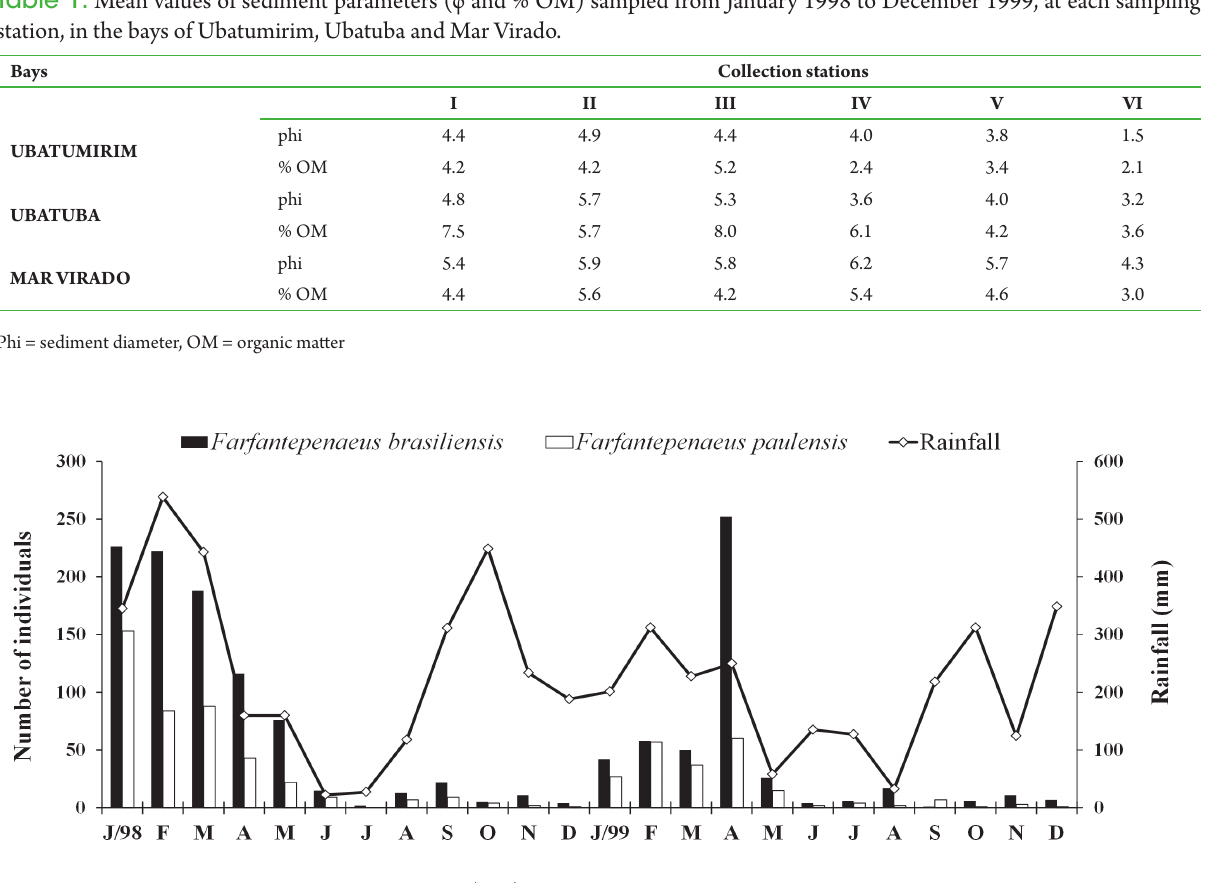
Figure 4. Cumulative values for monthly rainfall (mm) and number of individuals of Farfantepenaeus brasiliensis and F. paulensis sampled from January 1998 to December 1999 at Ubatuba, São Paulo. Table 2. Results of nested ANOVA for the number of individuals (log + 1 transformed) of Farfantepenaeus brasiliensis and F. paulensis collected in three bays of the Ubatuba region, from January 1998 to December